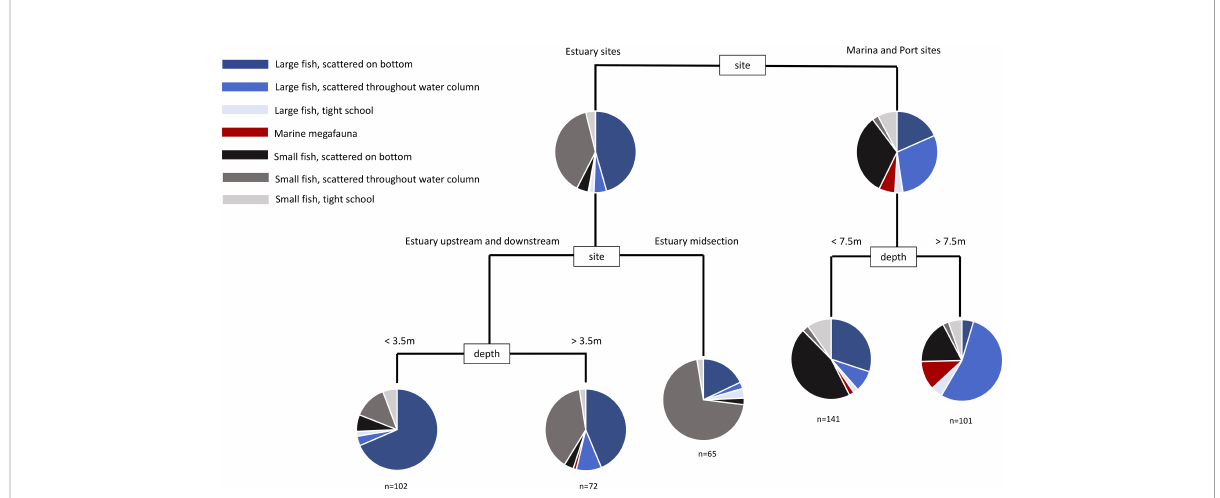
FIGURE 6 Multivariate classi fi cation and regression tree of the assemblage of mobile marine fauna from daytime sonar sampling. Sites were replicated at each sampling event (see Table